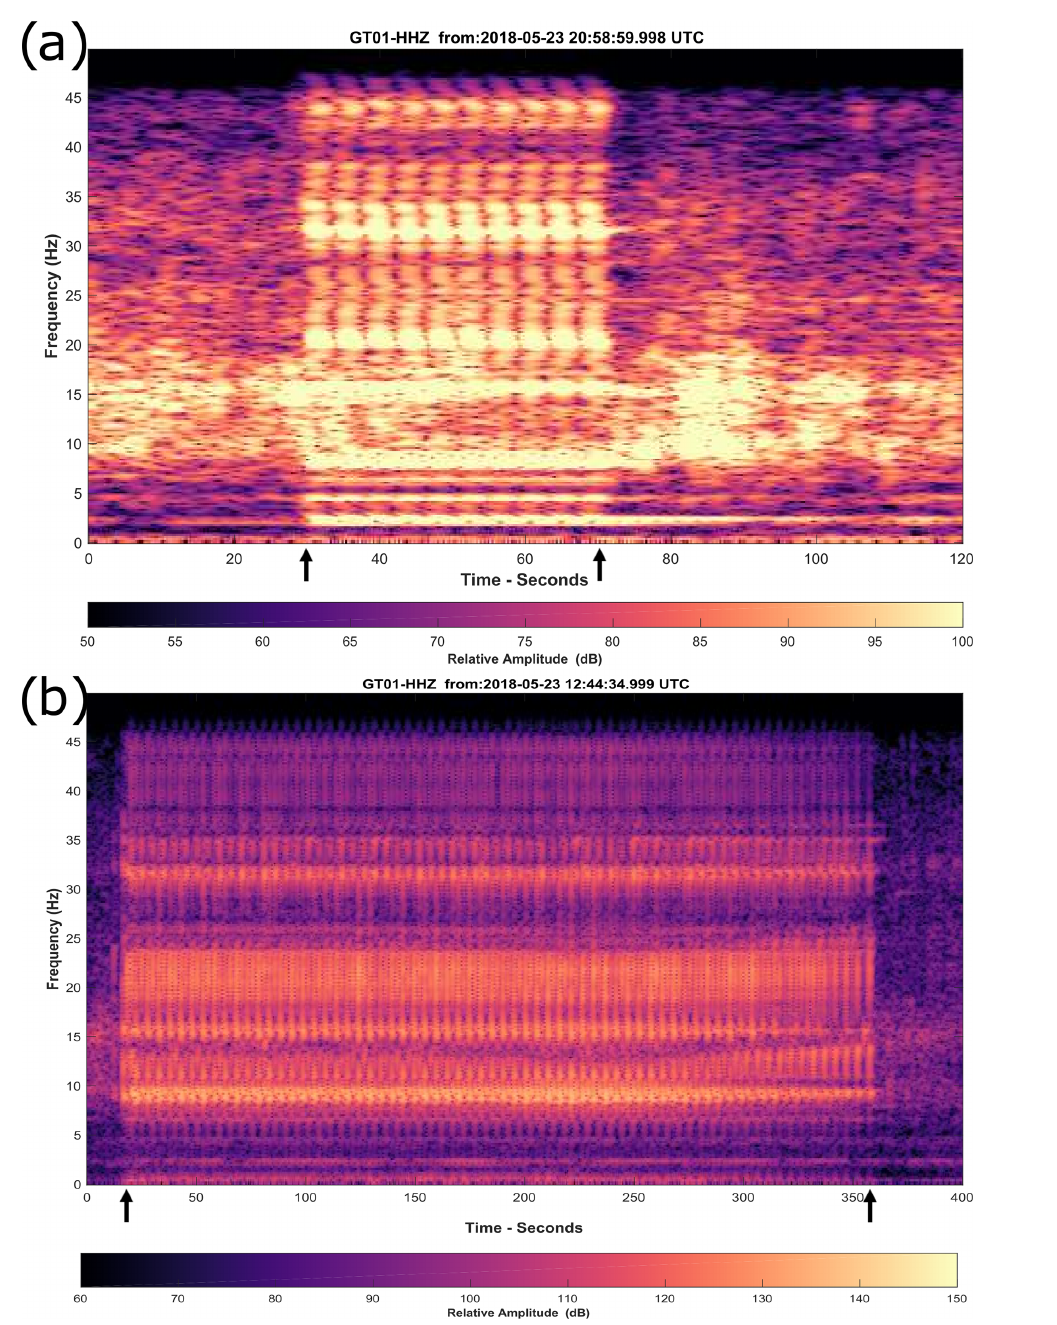
Figure 4. Zoomed-in spectrograms of the signals highlighted in Fig. 3. Panel (a) shows the 22:00LT (21:00UTC) chiming of Great George in which each peal is visible particularly in the 15–25Hz range. Panel (b) shows a spectrogram of the Charter Day chimes; note that the timescales are different and the colour range on panel (b) is larger than in panel (a) to prevent colour saturation. Arrows indicate the start and end of the bell-ringing